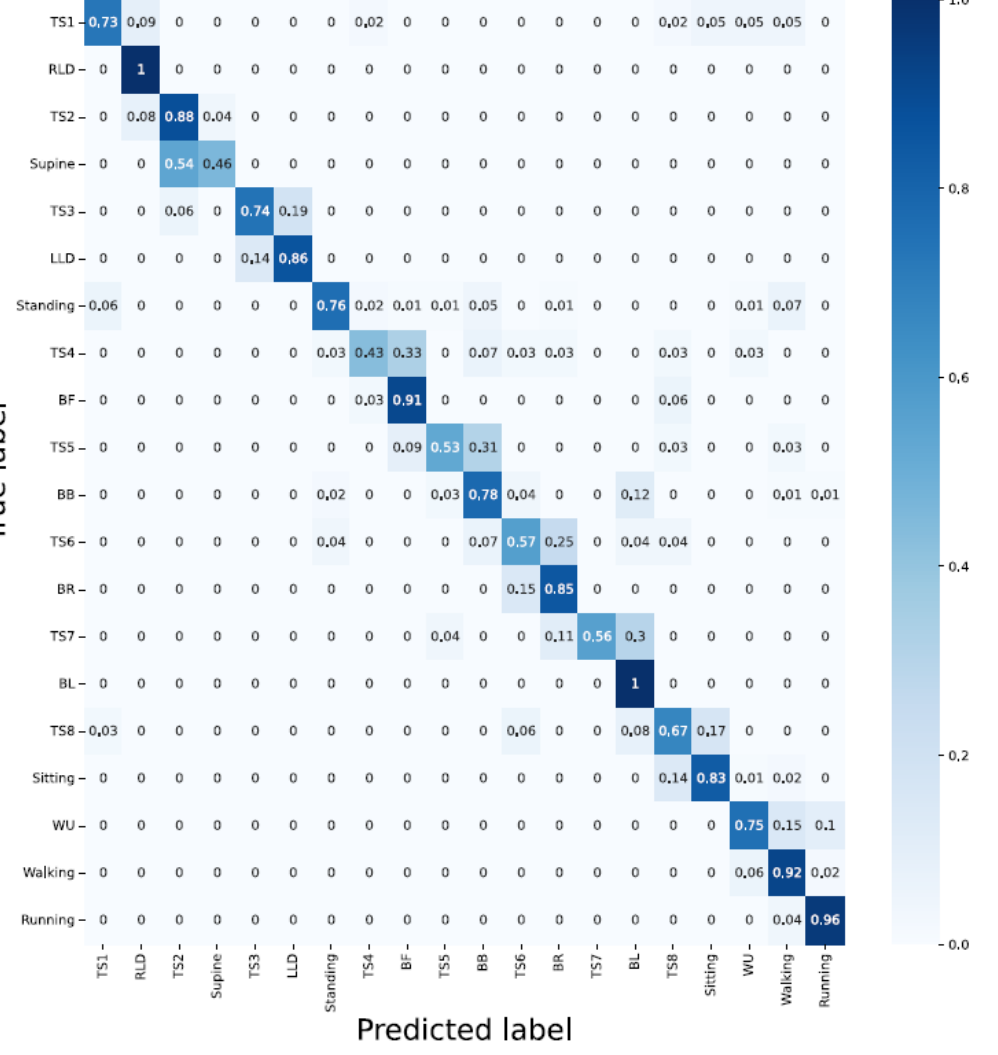
Figure 14. Using data fusion and PCA applied with LSTM architecture. Using two-second window downgrades the classification accuracy compared to ten-second windows, but TS1 and TS2 are detected with 73% and 88% classification accuracy,